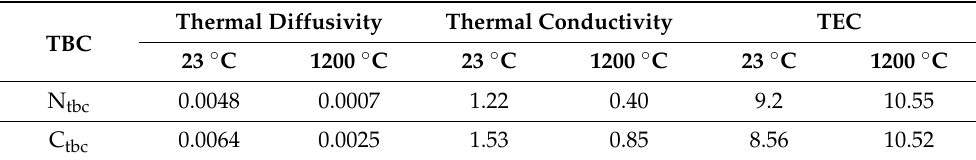
Table 3. Experimental data for N tbc and C tbc fabricated with t (cid:48) YSZ phase for two temperatures [92,93].